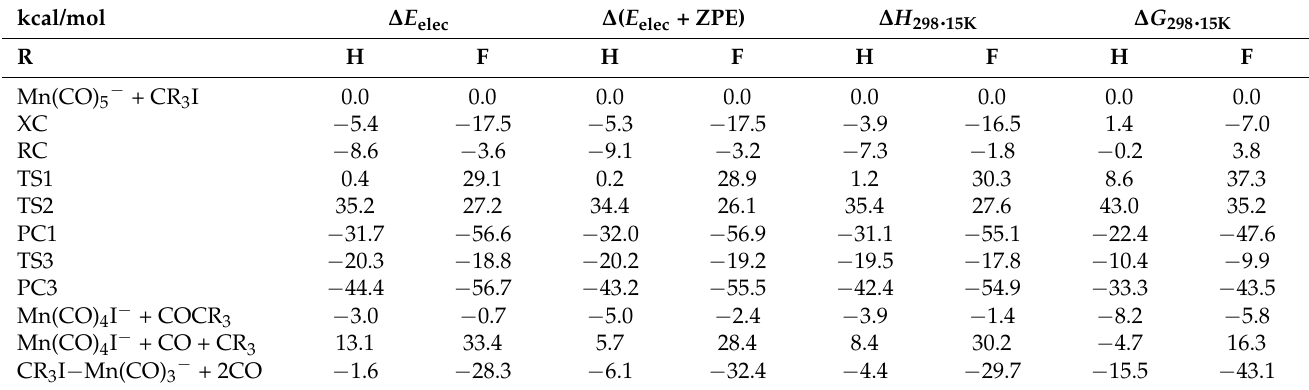
Table 1. Energetic values for stationary points on the PES of CR 3 I reacting with Mn(CO) 5 − . kcal/mol ∆ E elec ∆ ( E elec + ZPE) ∆ H 298 . 15K ∆ G 298 .